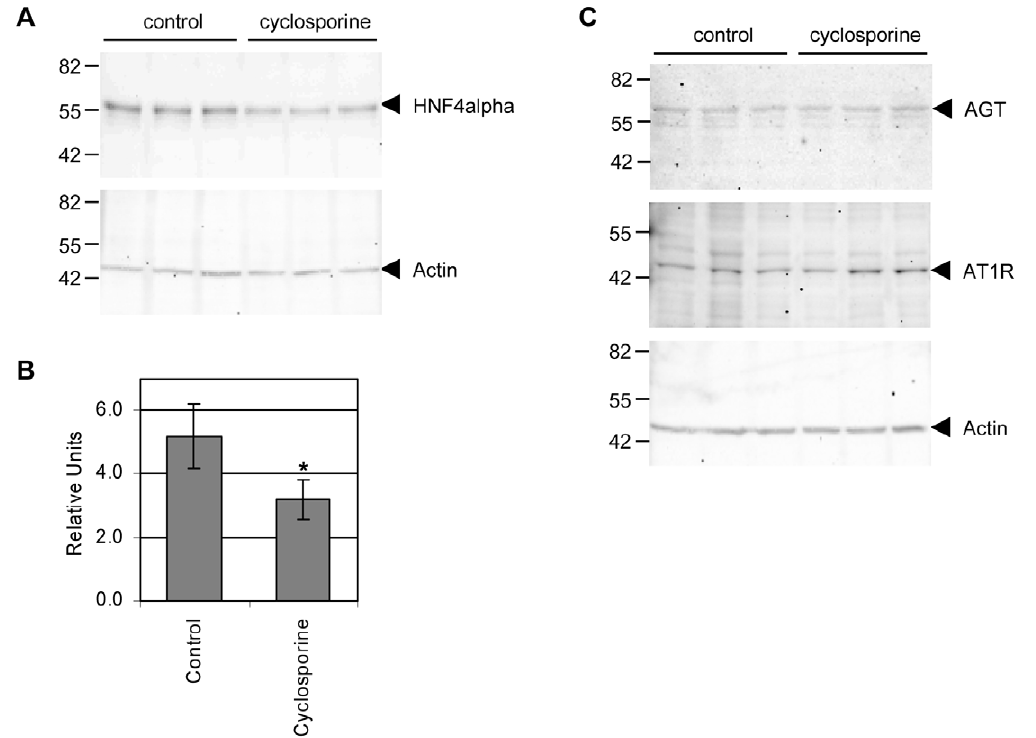
Figure 3. Cyclosporine inhibits protein expression of HNF4 a . A. HNF4 a western blotting of 20 m g HepG2 cell nuclear extracts (upper panel) and actin western blotting (lower panel) of 10 m g HepG2 cell nuclear extracts [control or cyclosporine treatment, 10 m g/ml for 72 h, n=3, respectively]. B. The graph panel represent the quantification of protein amounts for HNF4 a relative to the actin expression. Non-parametric Mann- Whitney-U-Test was used to compare cyclosporine treated and control groups. Results are considered significant at p , 0.05 (marked with an